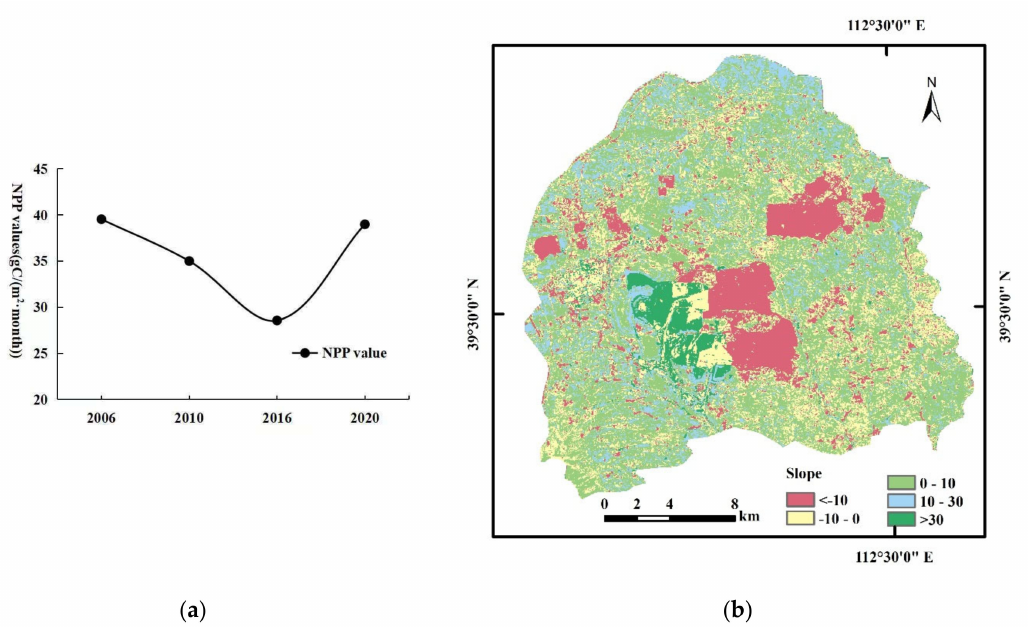
Figure 4. ( a ) The NPP change trend of the study area from 2006 to 2020 ( b ).the spatial distribution of the NPP change trend from 2006 to